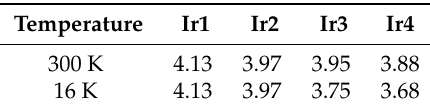
Table 1. Estimation of the formal Ir valence. The atomic positions for 300 K are employed from [8]. For the data at 16 K, we assume that Ir-O bond length changes with the same ratio as d 12 and d 34 . Namely, we use the same Ir-O bond lengths as at 300 K for Ir1 and Ir2, and values 0.96%-larger than at 300 K for Ir3 and